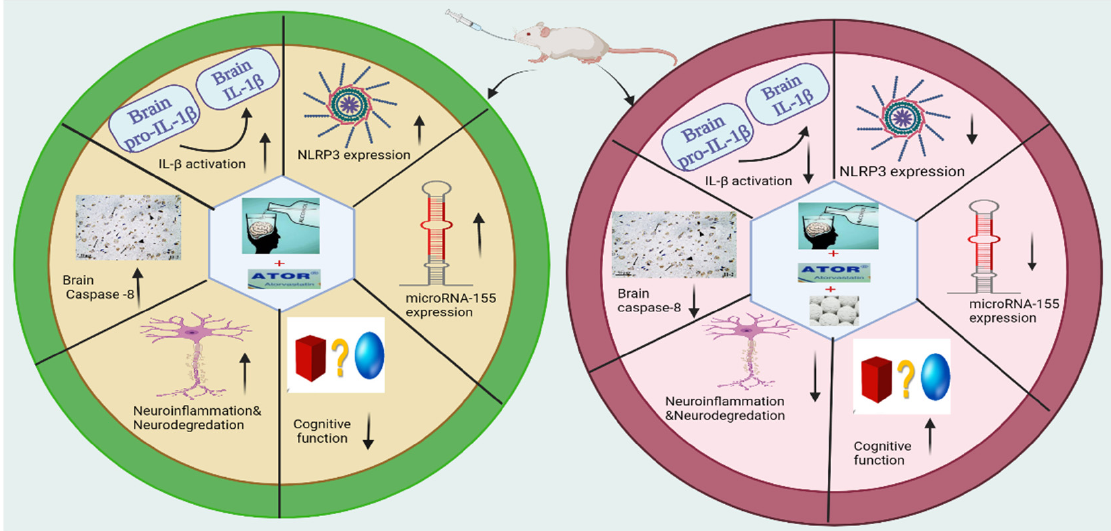
Figure 8. Molecular and cellular effects of ASA on cognitive dysfunction induced by alcohol and/or ATOR intake. ATOR